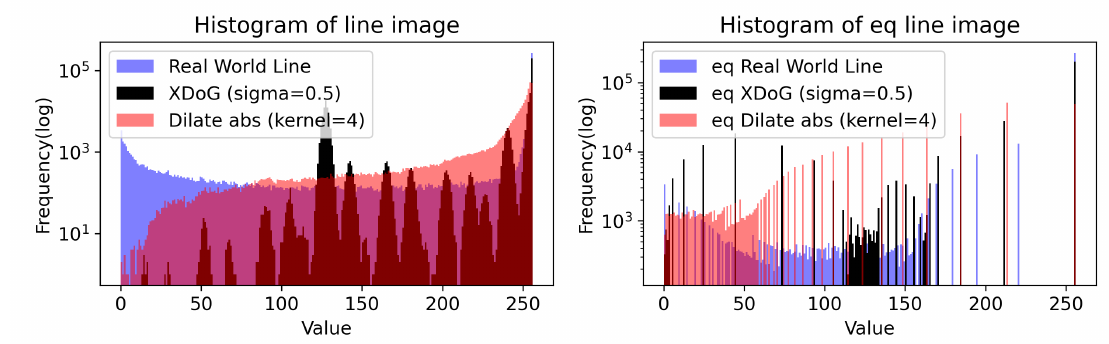
Figure 3. Histogram of line-art (eq: histogram equalization).